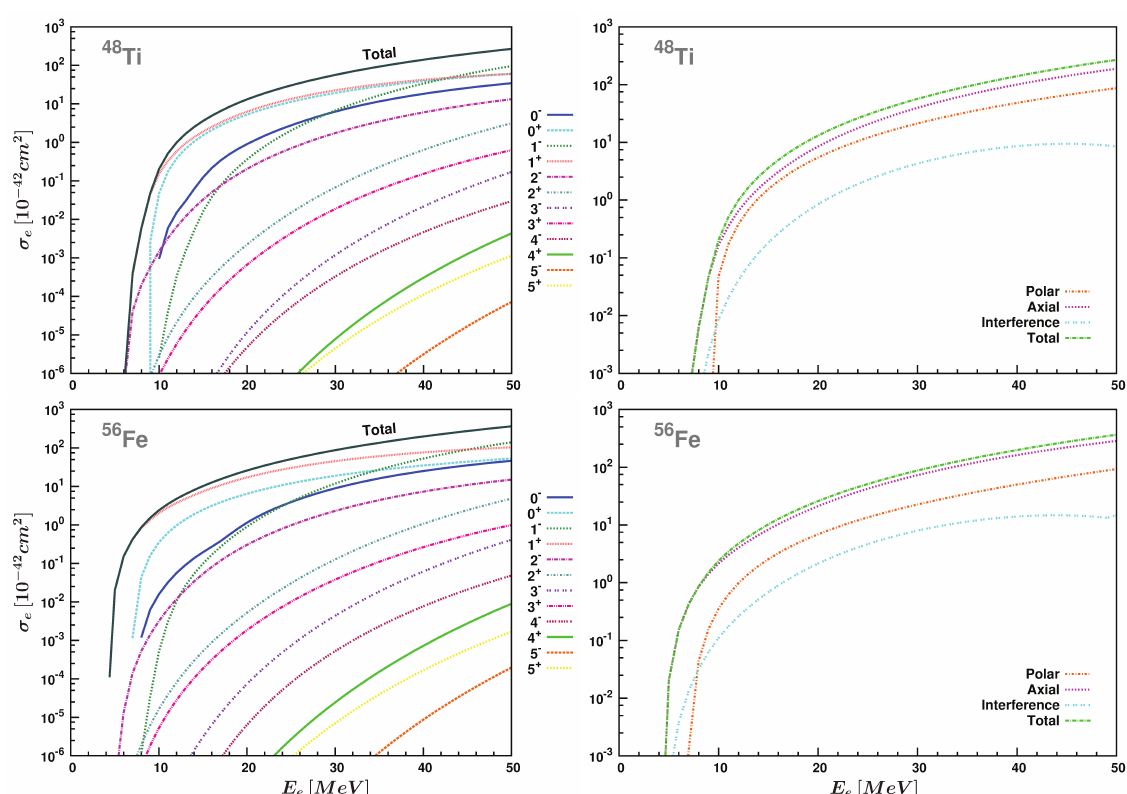
Figure 6. The same as Figure 5 but for 48 Ti ( e − , ν e ) 48 Sc and 56 Fe ( e − , ν e ) 56 Mn reactions.